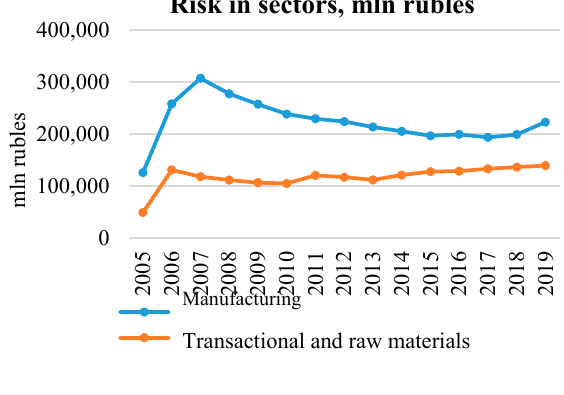
Figure 9. Profitability and risk ( above ) profit and risk ( below ) in the sectors in the Russian economy, 2004–2019 (measured in 2004 rubles, million rubles) 7 .